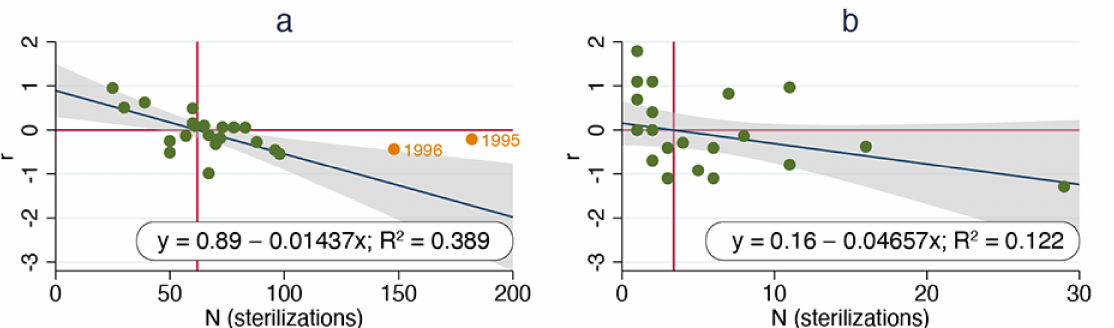
Figure 3. Calculated per capita growth rate vs. annual sterilization surgeries, ORCAT program 1995–2016 ( a ) and UCF program 1995–2018 ( b ). Dark blue lines are best-fit lines derived from linear regression; vertical red lines correspond to x-intercepts. Outliers (as determined via residual analysis) for ORCAT data are shown in orange and excluded from linear best-fit.